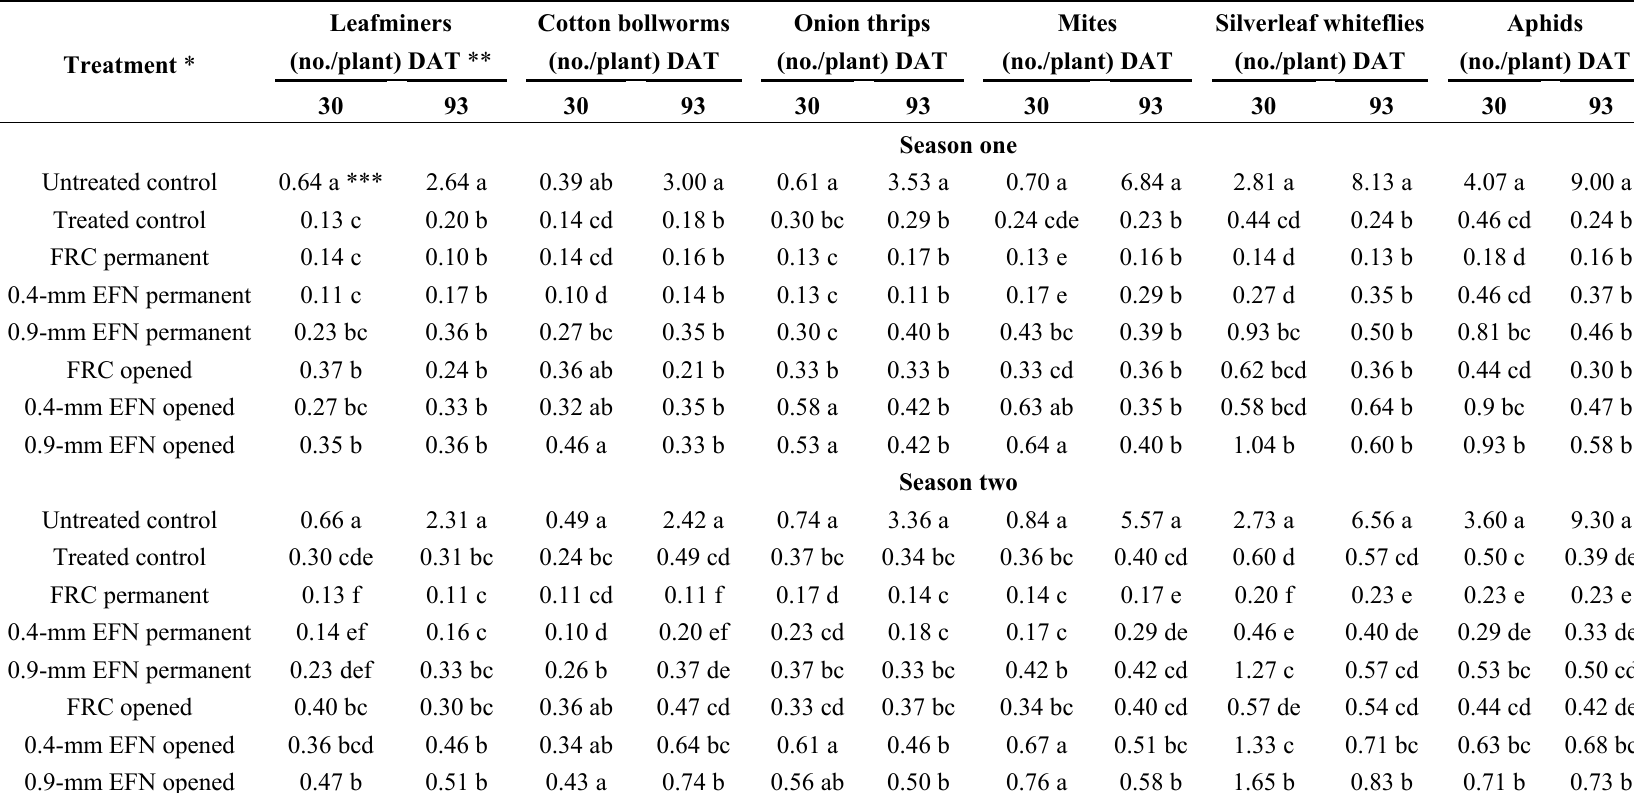
Table 1. Effects of floating row covers (FRC) and eco-friendly nets (EFN) on pest population during production of tomato in season 1 (May to October 2011) and 2 (October 2011 to March